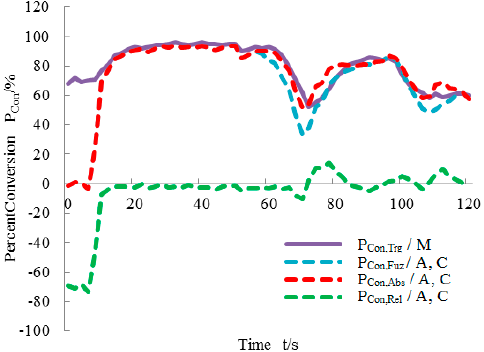
Figure 9. The four kinds of conversion efficiency after the correction.